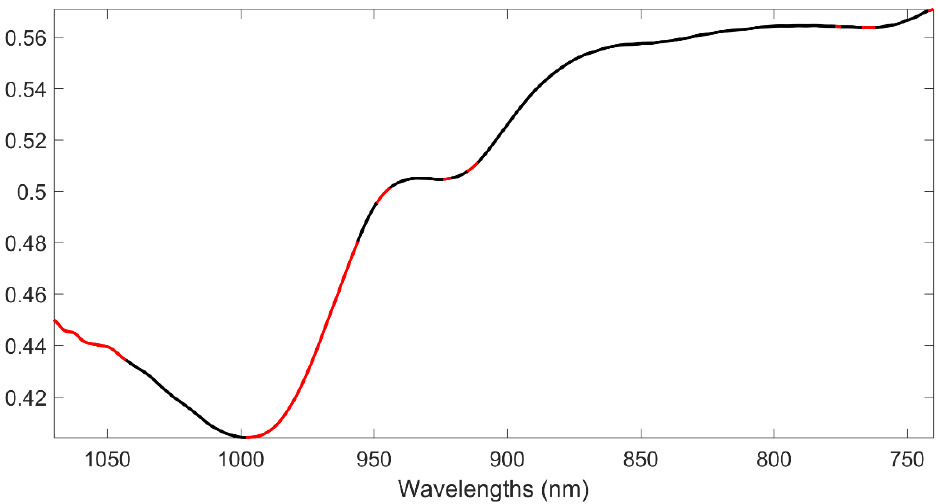
Figure 2. Variable importance in projection ( VIP) analysis. Average spectrum of training samples (black line). Spectral variables presenting VIP index >1 are highlighted in red.